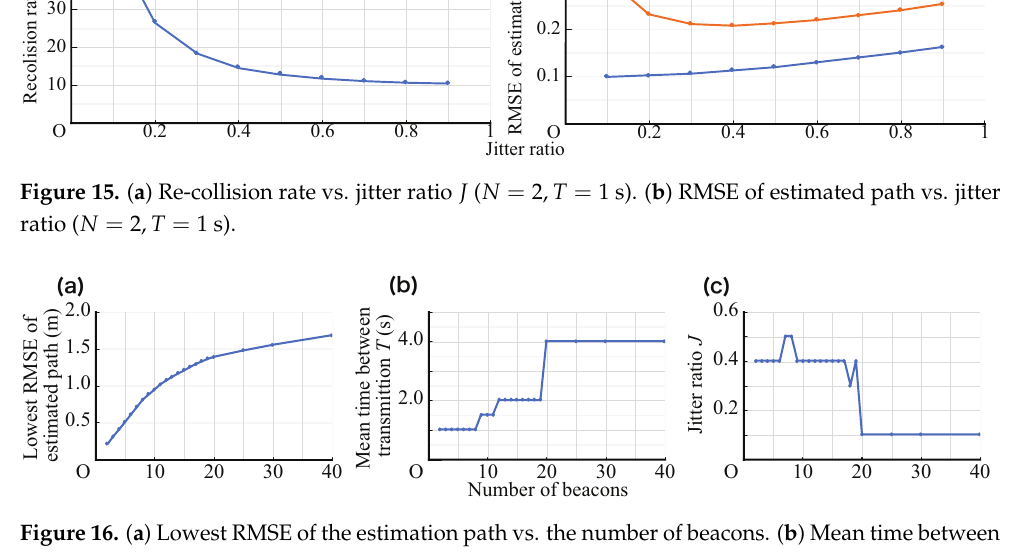
Figure 16. ( a ) Lowest RMSE of the estimation path vs. the number of beacons. ( b ) Mean time between transmissions T that achieved the lowest RMSE, which is shown in Figure 16a. ( c ) Jitter ratio J that achieved the lowest RMSE, which is shown in Figure